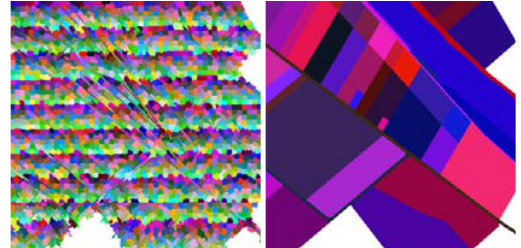
Figure 2. Region images representing super-pixels (left) and land use objects (right). The colours are assigned